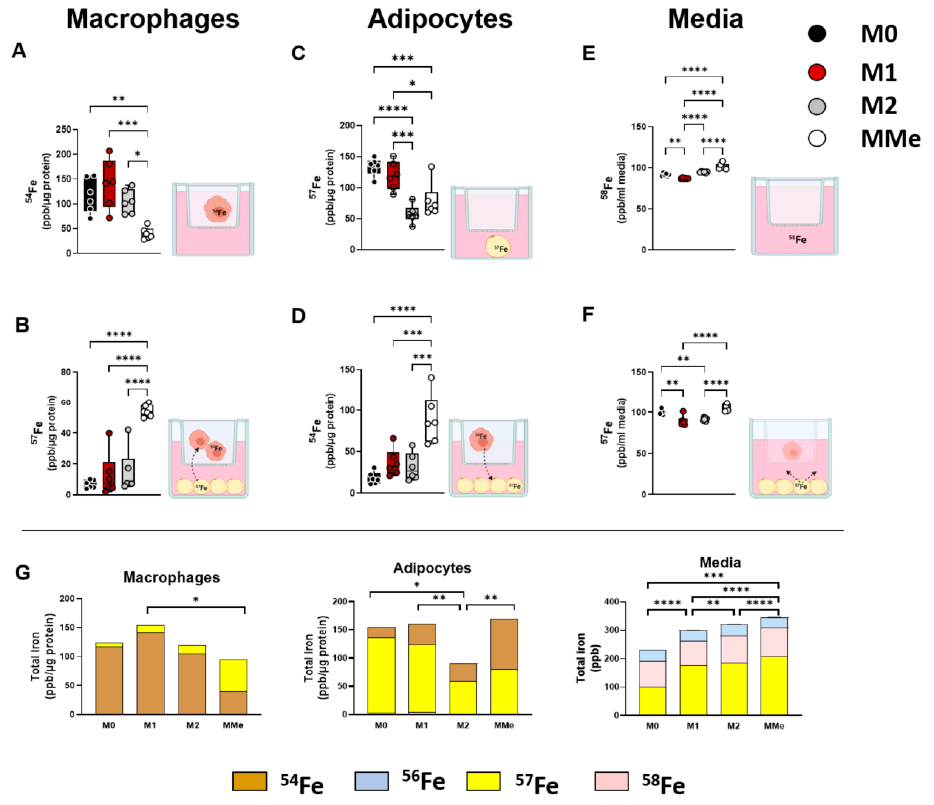
Figure 6. Increased iron communication between macrophages and adipocytes in obesogenic con- ditions . Macrophages were differentiated and polarized in 54 Fe while adipocytes were differentiated in 57 Fe. After complete differentiation and uptake of isotopes, macrophages and adipocytes were co-cultured for 48 h in media containing 58 Fe. 54 Fe, 57 Fe, and 58 Fe were measured in macrophages, adipocytes, and media at the end of the co-culture period. ( A ) 54 Fe remaining in macrophages. ( B ) 57 Fe transferred from adipocytes to macrophages. ( C ) 57 Fe remaining in adipocytes, ( D ) 54 Fe transferred from macrophages to adipocytes. ( E ) 58 Fe remaining in media. ( F ) 57 Fe transferred from adipocytes to media. ( G ) The total iron ( 54 Fe, 56 Fe, 57 Fe, and 58 Fe) in each cell type. Statistical analy- ses for all data were performed using two-way ANOVA with Tukey’s multiple comparison post-hoc tests for total iron only (individual isotopes are quantified in panels ( A – F ). * p < 0.05, ** p < 0.01, *** p < 0.001, **** p <